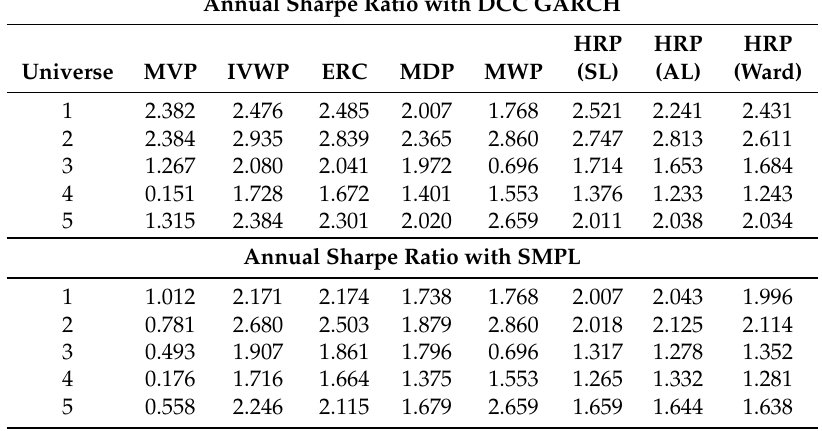
Table 10. The out-of-sample realized annual Sharpe ratio for the portfolios considered when they were rebalanced